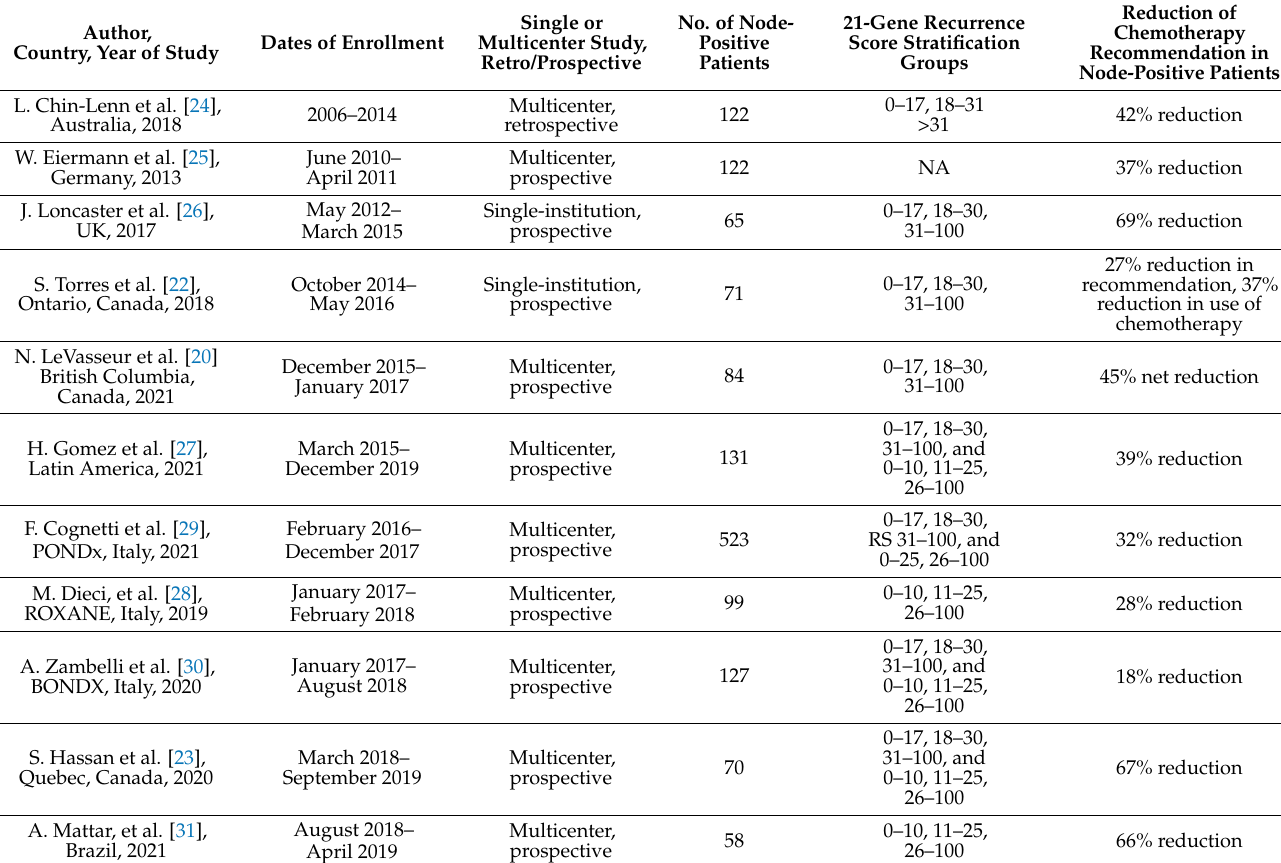
Table 1. Summary of decision impact studies in node-positive